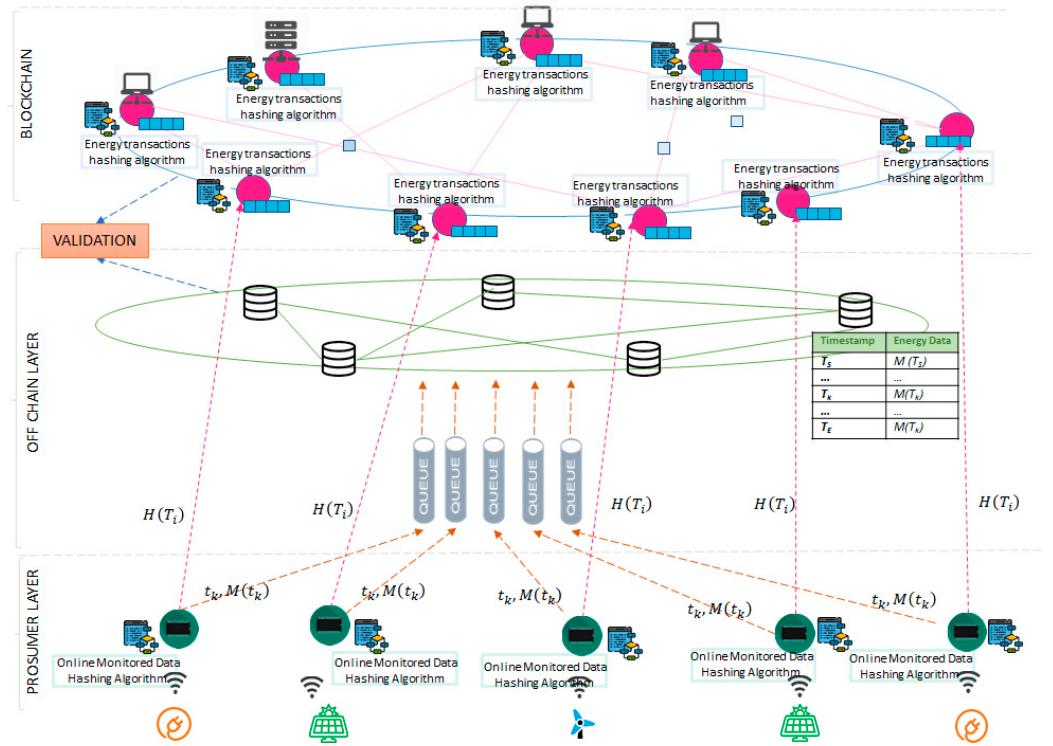
Figure 2. Proposed second tier solution for energy data storage.